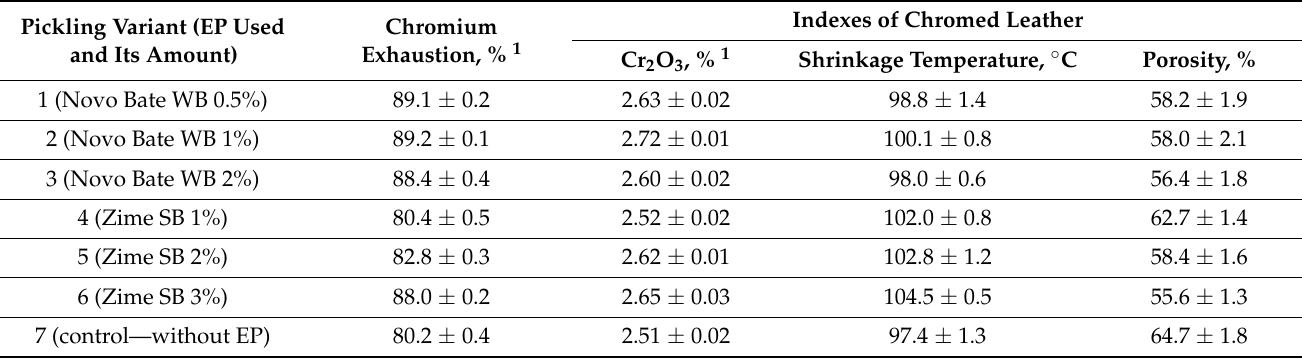
Table 2. Influence of pickling method on chroming and chromed leather